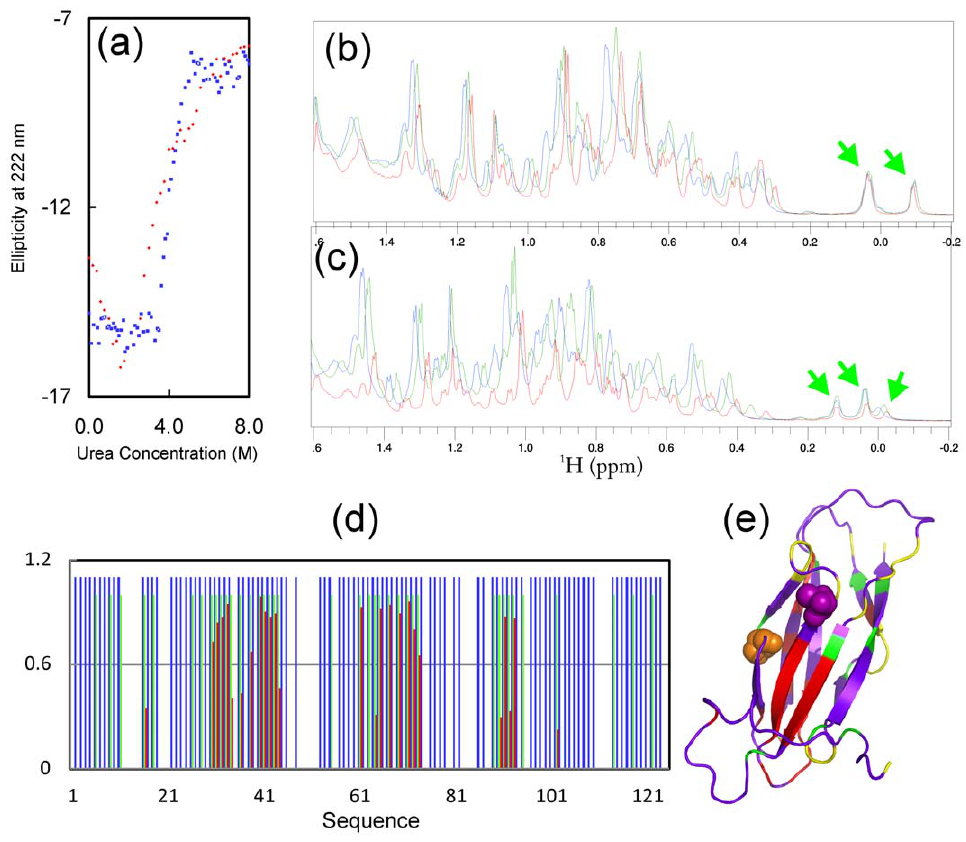
Figure 2. Stability of the T46I-MSP domain. (a). The urea-induced unfolding curves of the WT- (blue) and T46I- (red) MSP domains as reflected by changes of the ellipticity at 222 nm with urea concentrations ranging from 0 to 8 M. One-dimensional NMR spectra of the WT- (b) and T46I- (c) MSP domains at 15 u C (green) 25 u C (blue) and 45 u C (red). (d). Hydrogen-deuterium (H/D) exchange results for the WT-MSP domain. Blue bars: residues with HSQC peaks detectable in the 10 mM phosphate buffer at pH 6.8. Green bars: residues with HSQC peaks detectable 15 min after re-dissolving the lyophilized protein powder in D 2 O. Red bars: residues with HSQC peaks detectable 2.5 hr after re-dissolving the lyophilized protein powder in D 2 O. (e). The crystal structure of the MSP domain with the H/D exchange results mapped. The yellow is to indicate the residues undetectable even in the 10 mM phosphate buffer at pH 6.8.